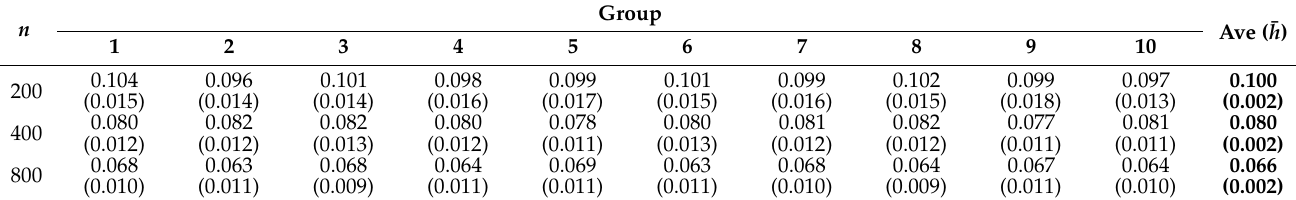
Table 6. Averages (and standard deviations) of the bandwidths.